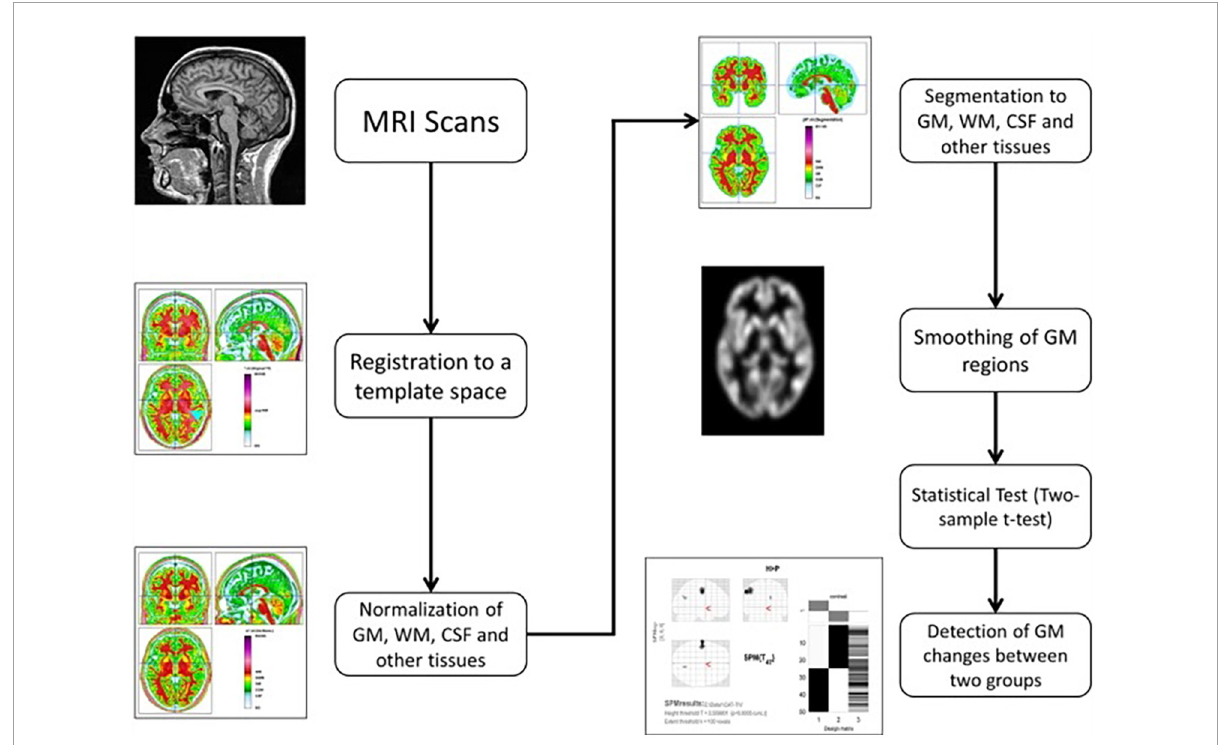
FIGURE1 The processing framework of VBM analysis using the CAT12 toolbox of SPM12 software